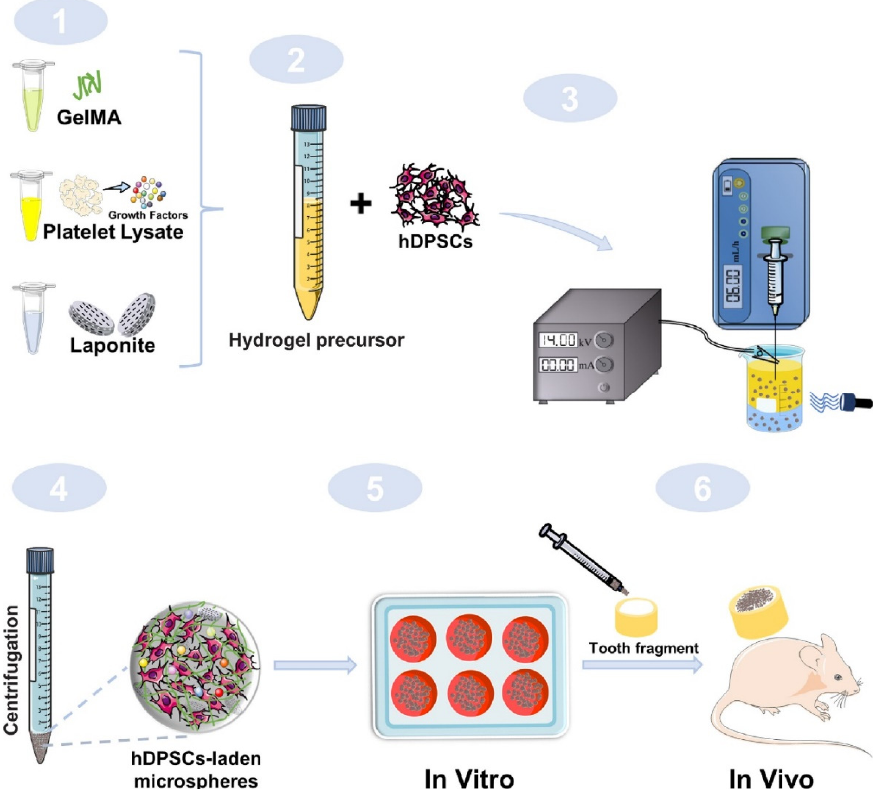
Figure 3. Schematic diagram of fabrication of GelMA/PL/Laponite microspheres and its applica- tion for endodontic regeneration. (1) GelMA, Platelet Lysate, and Laponite formed a hydrogel precursor. (2) Hydrogel precursors mixed with hDPSCs to make microspheres. (3) Preparation